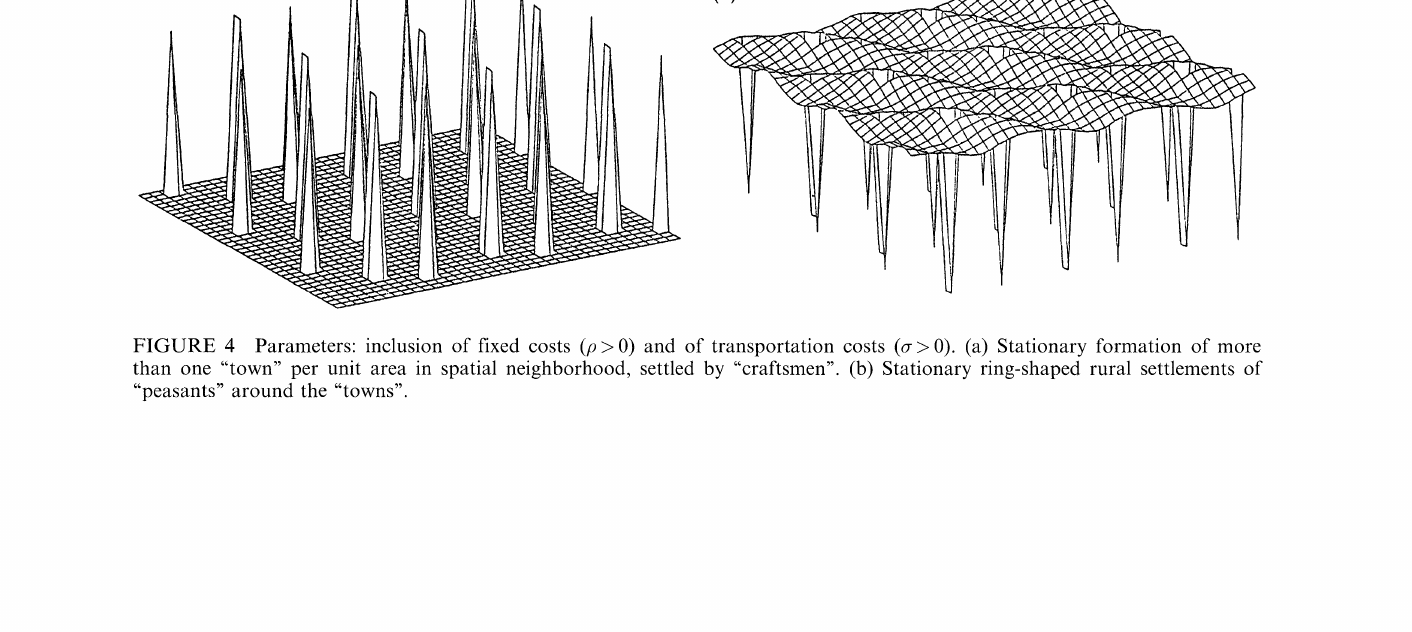
FIGURE 3 The interrelation of the elements of the macromodel for the formulation of settlement structures.